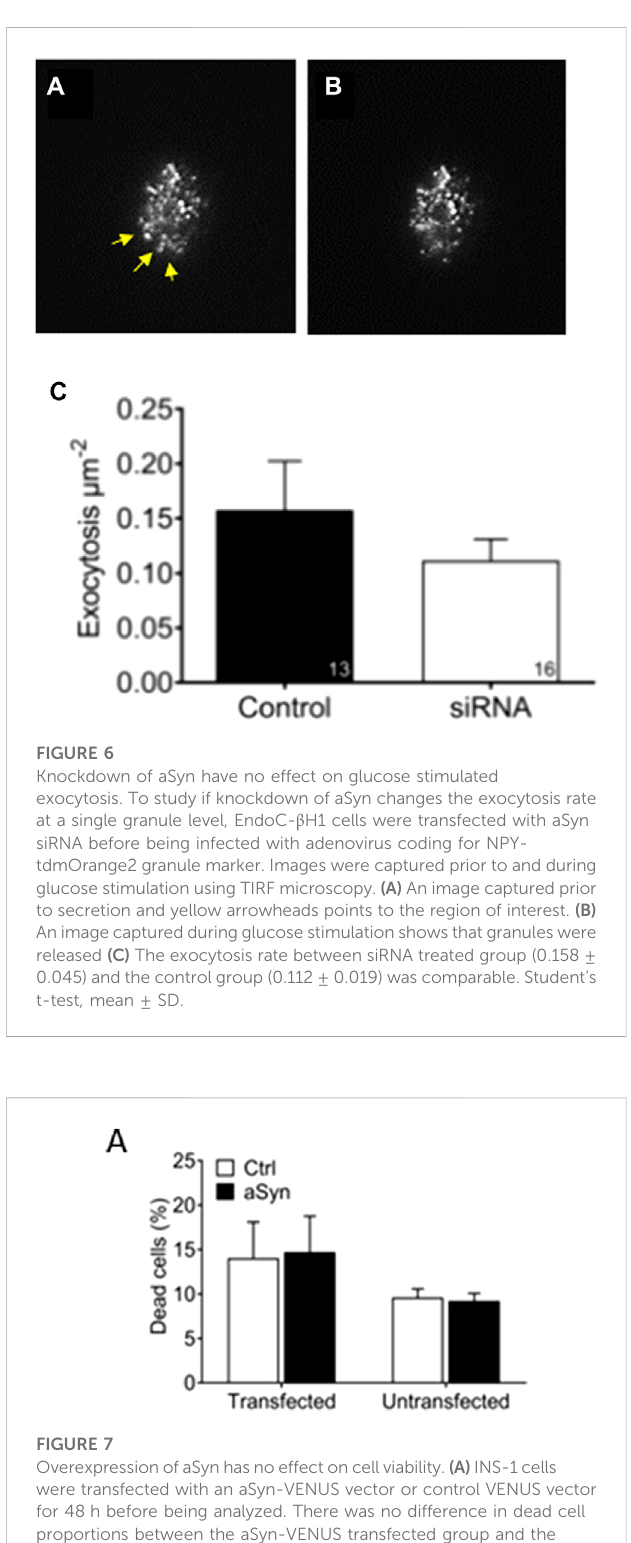
(2 μ M) and aSyn preformed fi brils (corresponding to 7 μ M peptide), they also identi fi ed a delayed IAPP fi brillation and the lag phase for IAPP aggregation changed from 0 – 100 min.